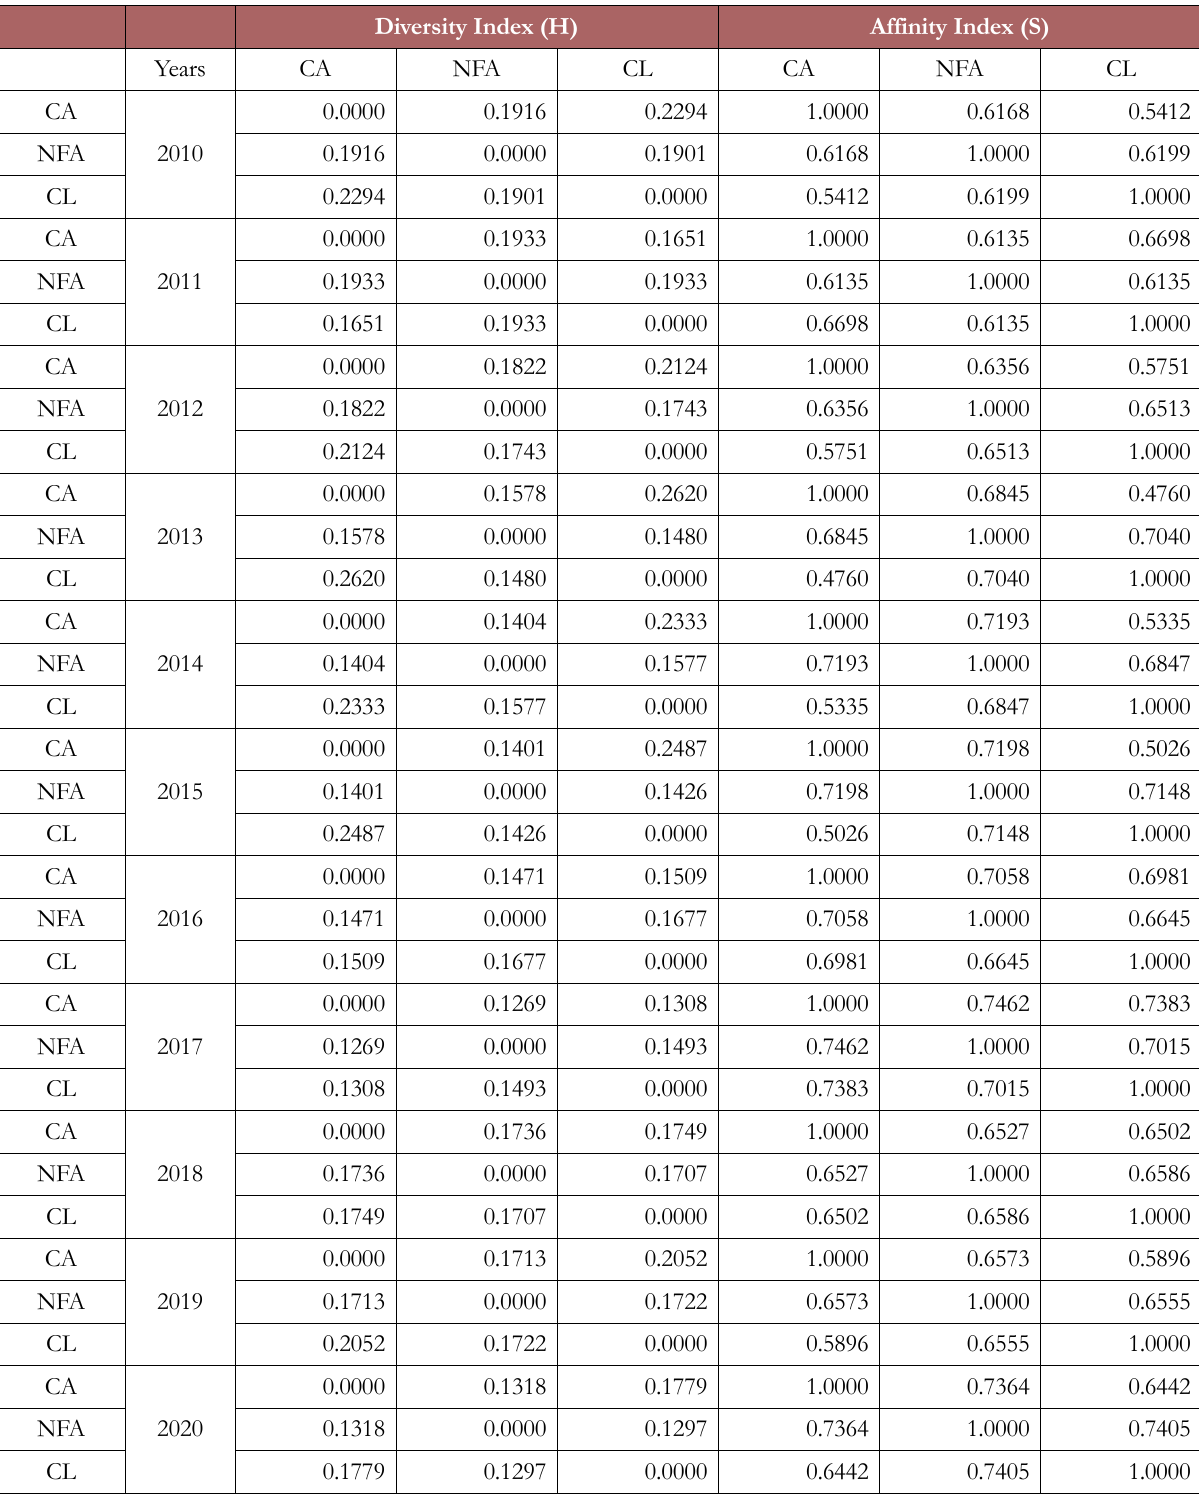
Table 4. Diversity index and affinity index from 2010 to